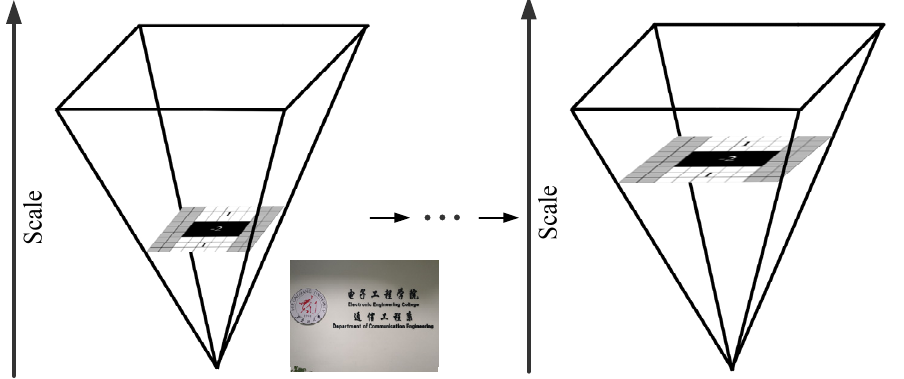
Figure 5. Pyramid image. The original image size remains unchanged, but the template size is is changed.